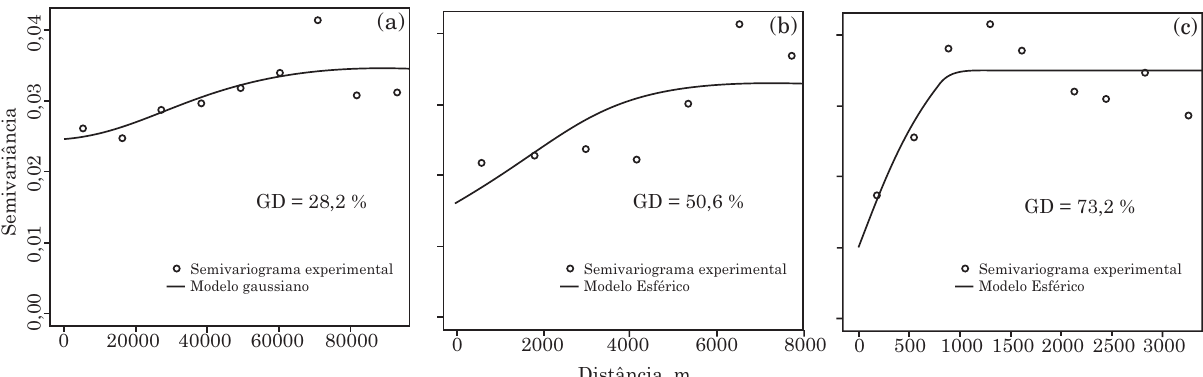
Figura 5. Ajuste dos semivariogramas teóricos aos dados do índice de qualidade do solo associado à recarga